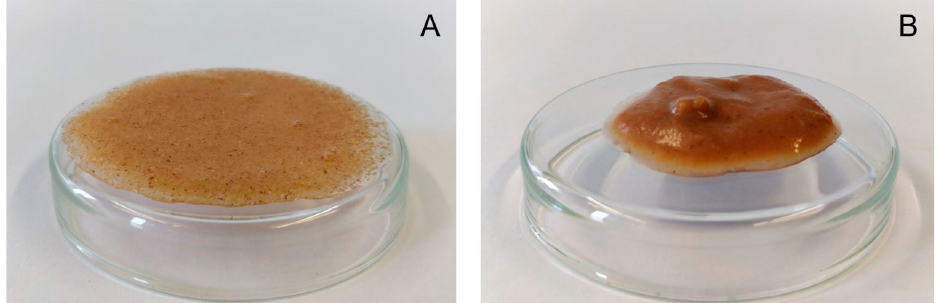
Figure 6. Effect of screw speed and water content on complex viscosity η * at ( A ) 100 °C barrel temperature and ( B ) 120 °C barrel temperature.